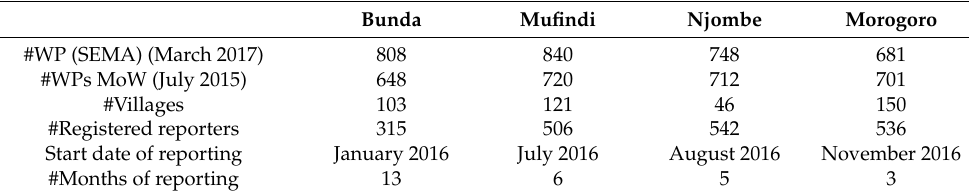
Table 3. Registered WP in each district.